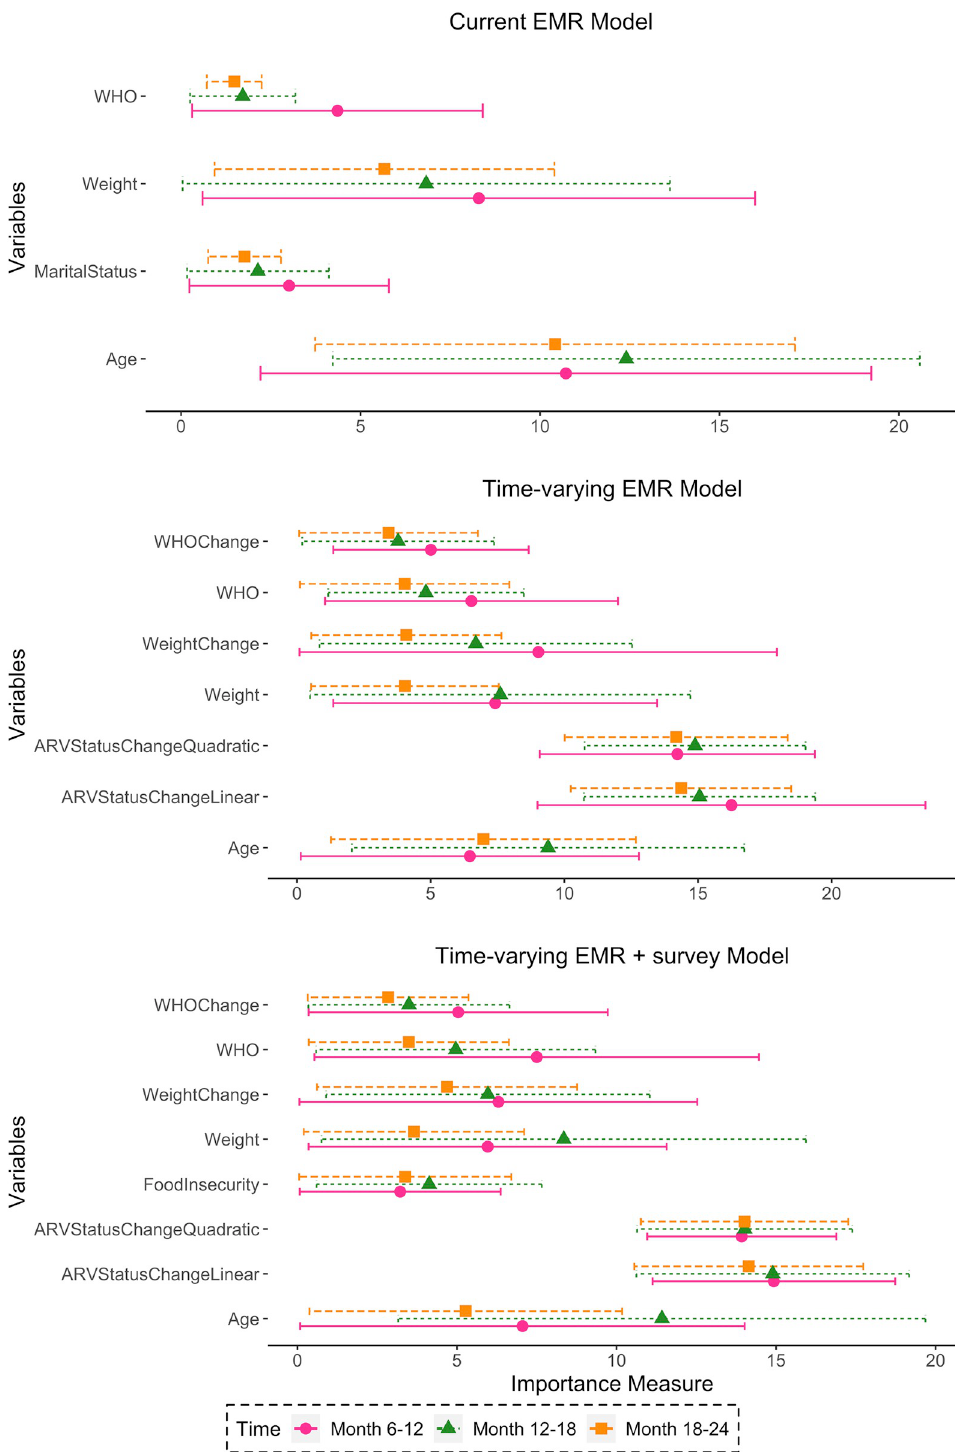
Fig 2. Variable importance for models predicting disengagement from HIV care, Tanzania. Plots show the top 4 most important variables for current EMR model, the top 7 for time-varying EMR model and the top 8 for time-varying EMR+ survey information